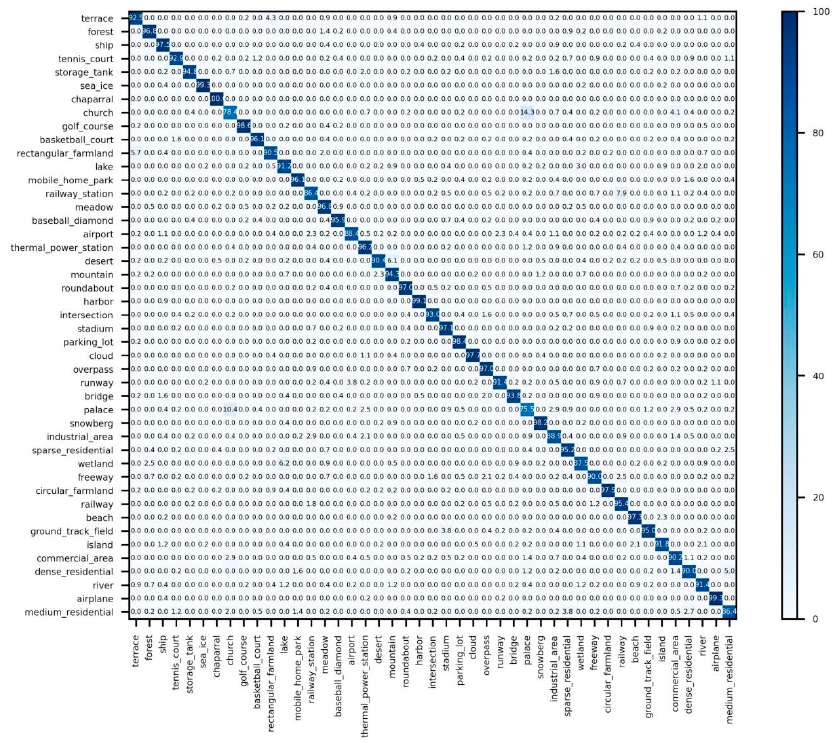
Figure 10. Confusion matrix of fine-tuned results on NWPU-45 20% training proportion. Remote Sens. 2022 , 14 , x FOR PEER REVIEW